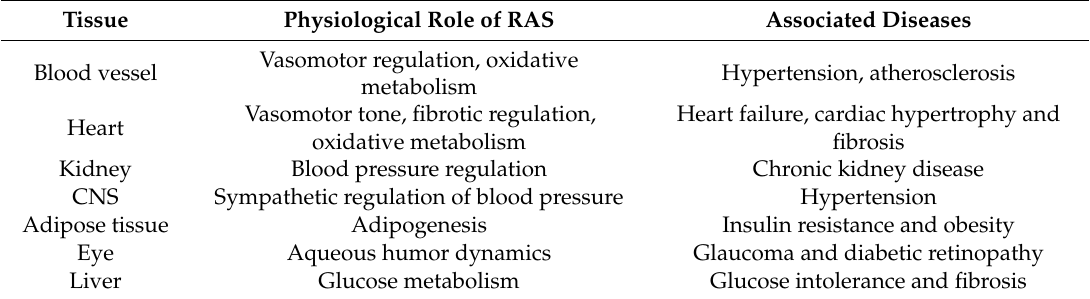
Table 2. The physiological and pathophysiological role of RAS in di ff erent